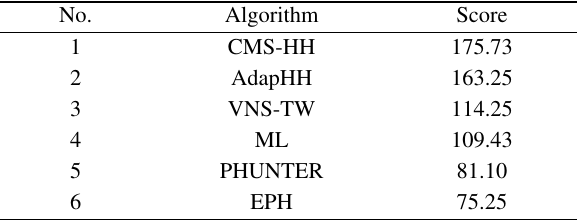
Table 14 Ranking of CMS-HH with five comparison